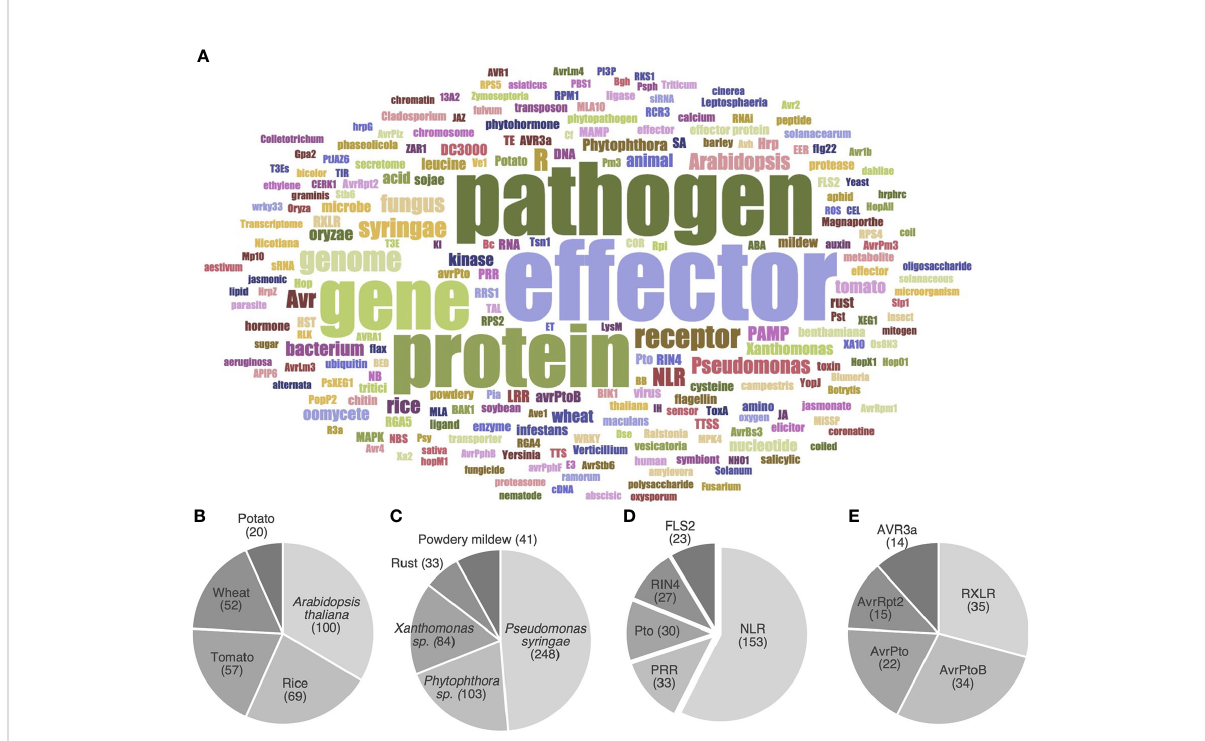
FIGURE 4 HIPEs mainly address a handful of model organisms and proteins. (A) Word cloud displaying the most frequent words referring to organisms or molecules in the title and abstract of the HIPEs. The word cloud was built using a fi ltered text fi le including HIPEs metadata (publication title and abstract) deprived from words that did not explicitly refer to organisms or molecules. Word colors were randomly generated to assist visual word discrimination. The word cloud displays 200 words. The size of the words positively correlates with their frequency in the text fi le. A top fi ve of plant organisms (B) , plant-associated pathogens (C) , immune receptors (D) and pathogen effectors (E) was identi fi ed based on Dataset 2. The following speci fi c keywords were considered for the following topics: Arabidopsis thaliana ( ‘ Arabidopsis ’ and ‘ thaliana ’ ), Pseudomonas syringae ( ‘ Pseudomonas ’ , ‘ syringae ’ , ‘ DC3000 ’ and ‘ pst ’ ), Phytophthora sp. ( ‘ Phytophthora ’ , ‘ infestans ’ , ‘ ramorum ’ and ‘ sojae ’ ), Xanthomonas sp. ( ‘ Xanthomonas ’ , ‘ campestris ’ and ‘ oryzae ’ if used in a meaningful context), Powdery mildews ( ‘ Powdery ’ and ‘ mildews ’ ), NLR ( ‘ NLR ’ , ‘ LRR ’ , ‘